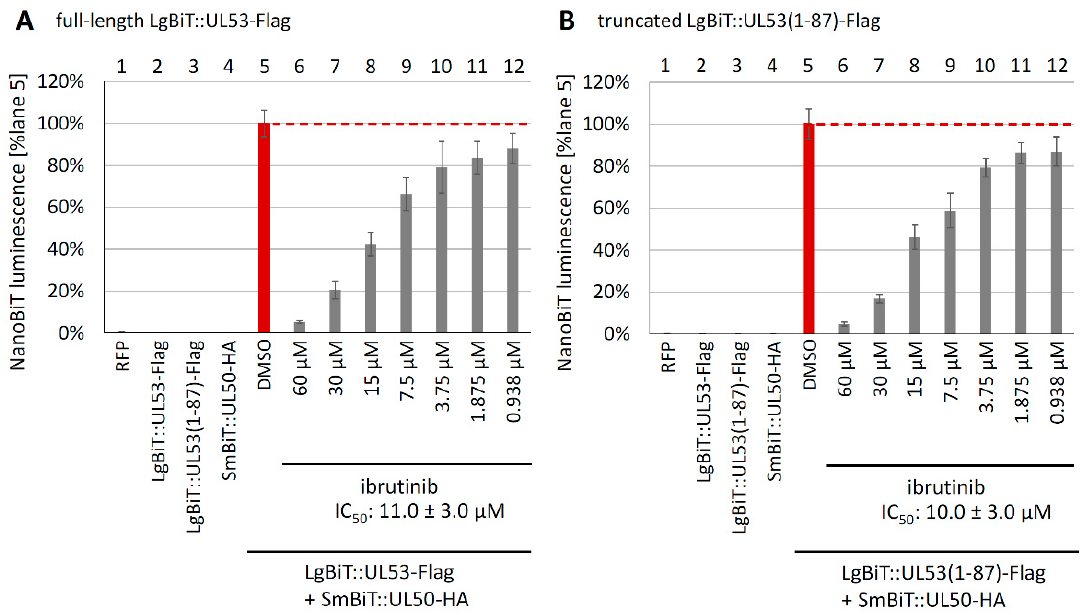
Figure 9. Inhibitory impact of serial concentrations of ibrutinib on core NEC interaction. The